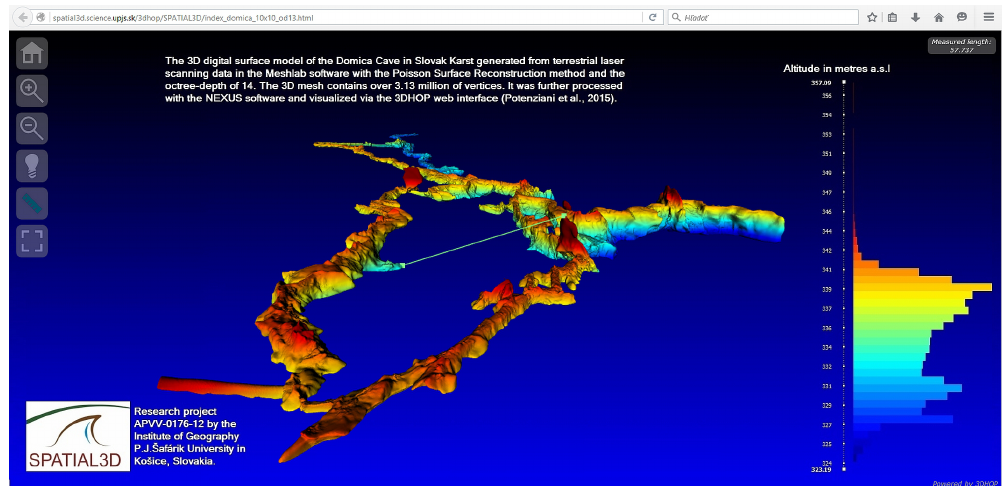
Figure 17. Print-screen snapshot of the Web interface allowing for interactive viewing and basic measurements of the 3-D surface model of the Domica